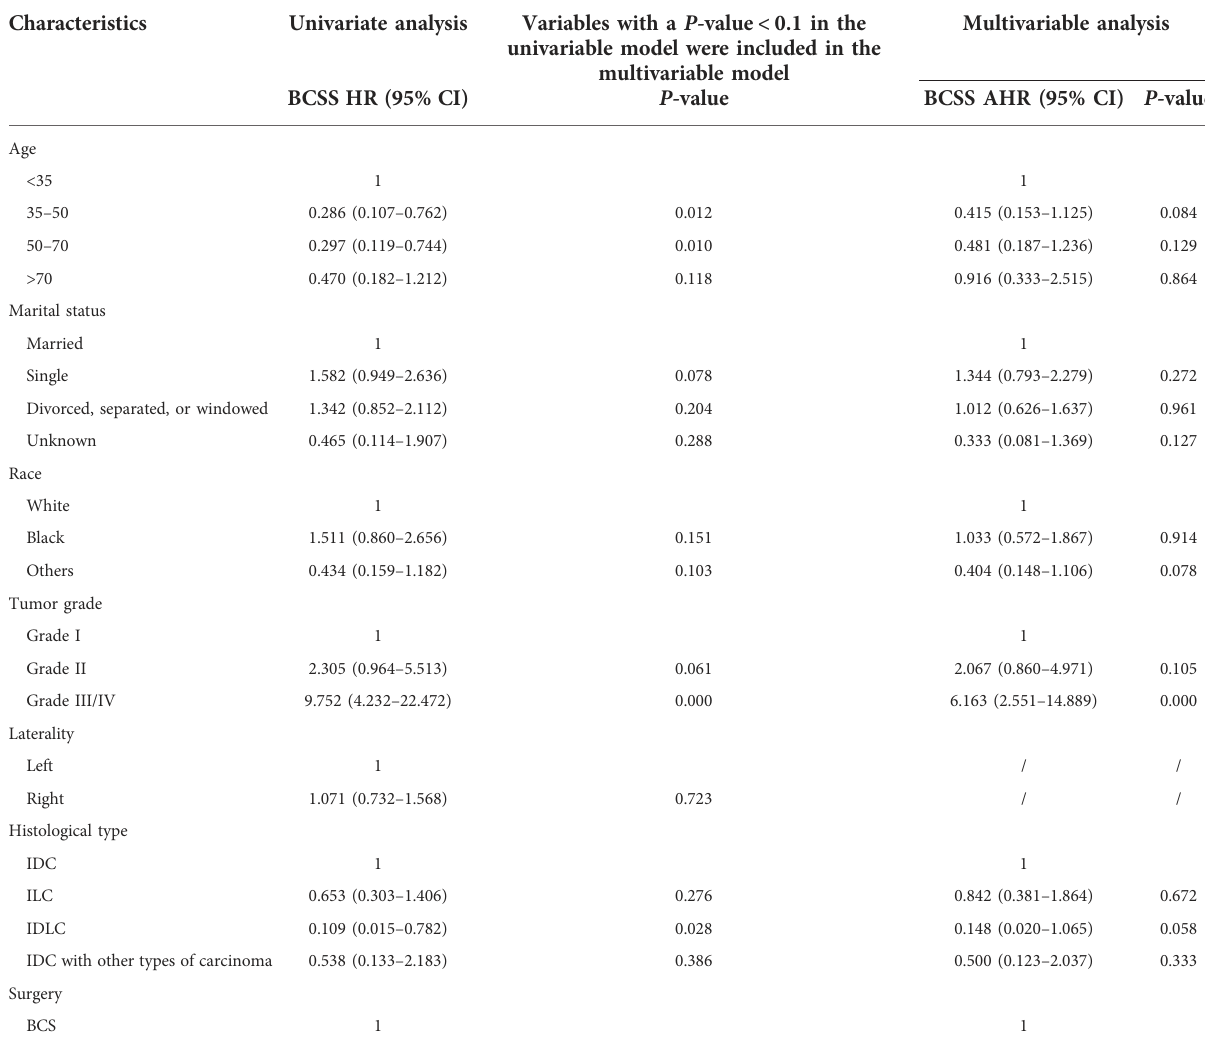
TABLE 3 Univariate and multivariate Cox analysis of breast-cancer-speci fi c survival in patients who had one or two sentinel lymph node micrometastases and underwent sentinel lymph node biopsy alone.